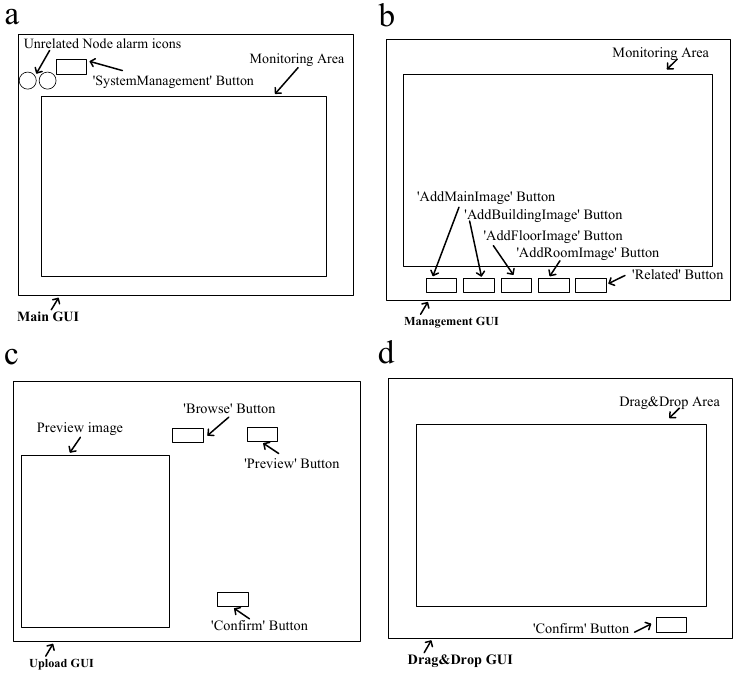
Figure 3. Function and component layouts of the webpages for geographic map data uploading and simulated environment construction ( a ) Main GUI. ( b ) Management GUI. ( c ) Upload GUI. ( d ) Drag and drop GUI.